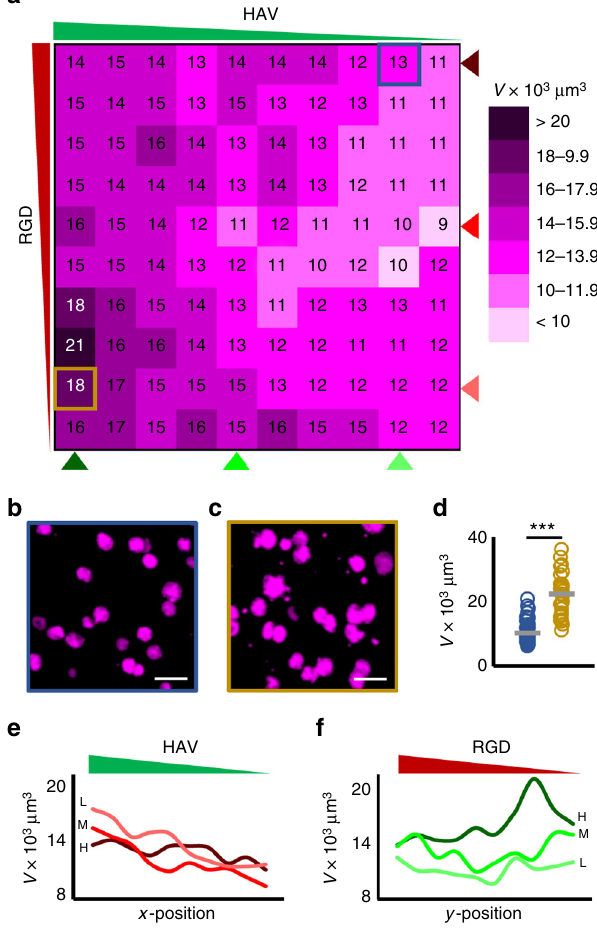
Fig. 5 Effects of orthogonal HAV and RGD gradients on transcription factor Sox9 expression. a Heat map of average intensities of Sox9 fl uorescence across 100 bins (10 by 10 array) for cultures of mesenchymal stem cells (MSCs) after 1 day. b Representative maximum projection images of bins corresponding to ( b ) high RGD, low HAV (outlined blue) and ( c ) low RGD, high HAV (outlined gold) qualitatively show low and high nuclear Sox 9, respectively. d Single-cell analysis of nuclear Sox9 fl uorescence for these same groups from b and c . e RGD curves at a fi xed concentration (light, medium, and dark red correspond to low “ L ” , medium “ M ” , and high “ H ” RGD concentrations, respectively) show a decreasing trend along HAV concentration gradient. In contrast, ( f ) HAV curves at a fi xed concentration (light, medium, and dark green correspond to low “ L ” , medium, “ M ” , and high “ H ” HAV concentrations, respectively) show an increasing trend along RGD concentration gradient, with highest values occurring along high HAV concentration curve at a low RGD concentration. n > 50 cells in samples shown in b and c , *** p < 0.001. Scale bars: 50 µ m